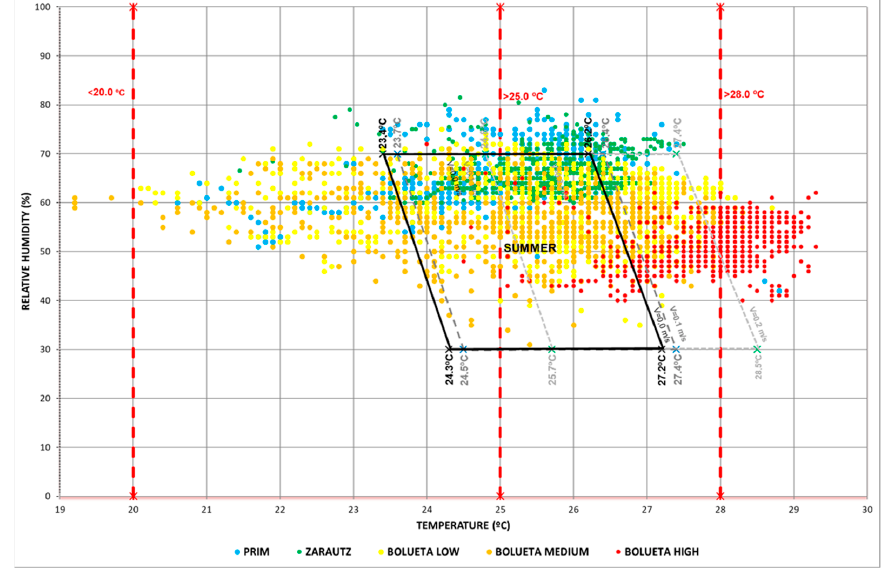
Figure 20. Summer comfort diagram for August 2020. Source: authors.